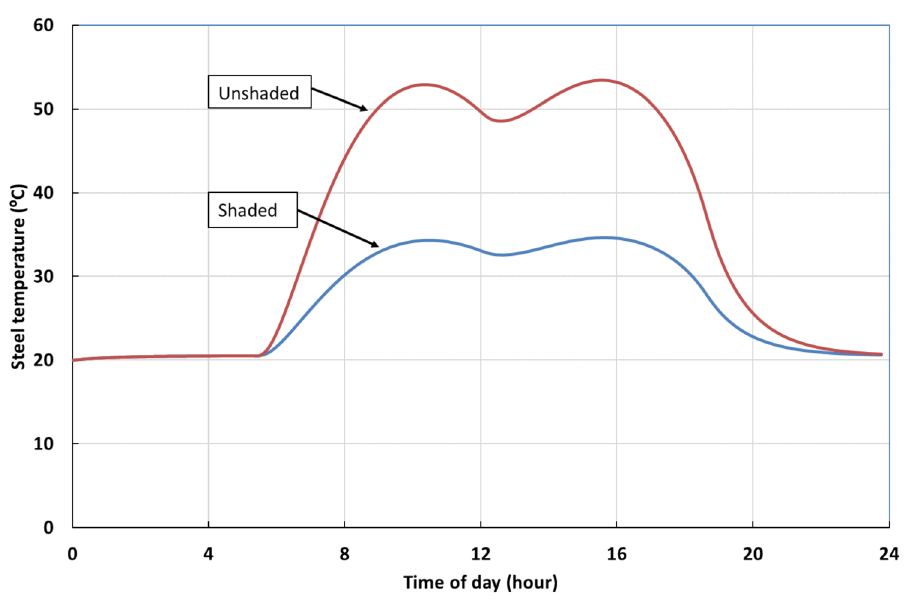
Figure 10. Container steel wall temperature in mid-summer shaded by the solar array mounted on top of the container vs. unshaded, where the solar panel array is mounted away from the container. Mounting the solar panel array on top of the container results in a reduction in the steel temperature of the roof surface, which in turn results in a lower power requirement for the refrigeration compressor to maintain the inside of the cold storage at a constant of 5 ◦ Celsius, as shown on Figure 11.